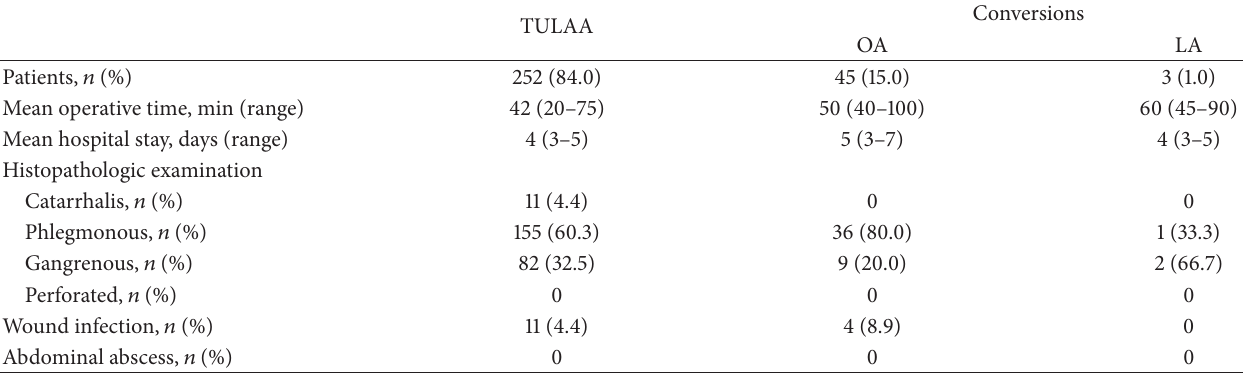
Table 2: Results of the 300 acute uncomplicated appendicitis in patients treated using a transumbilical laparoscopic-assisted approach.